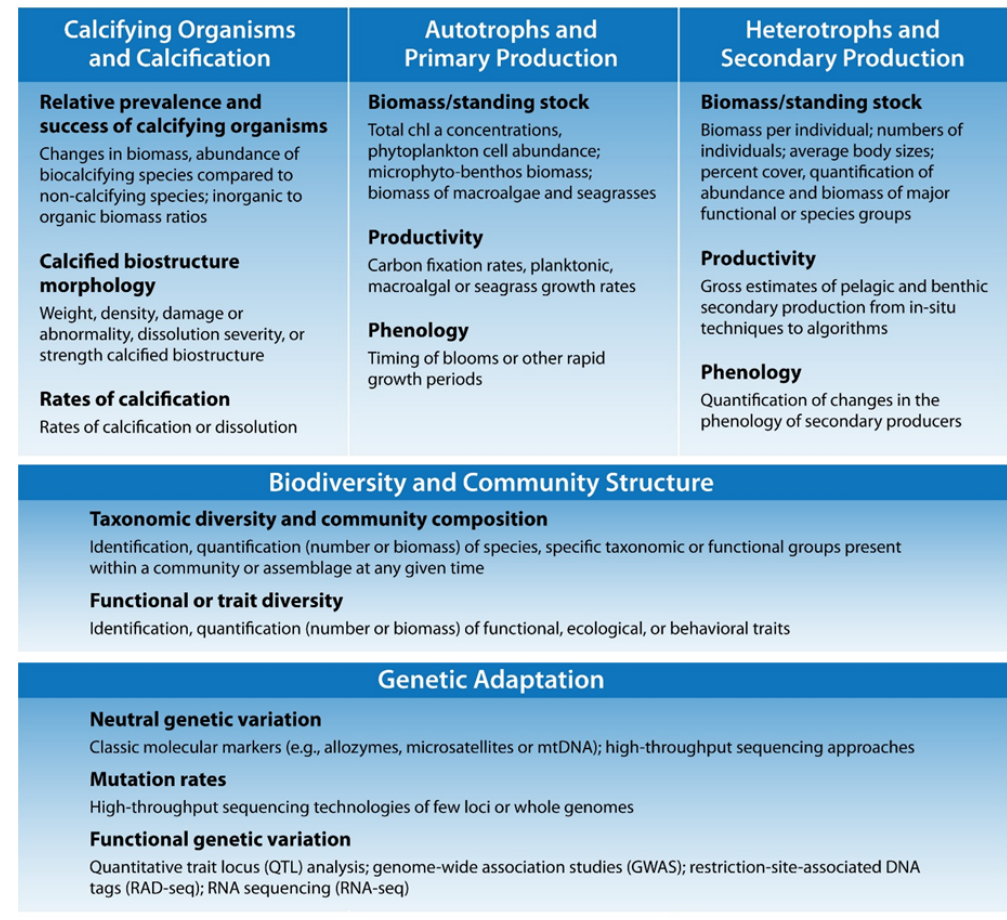
Figure 1. Five fundamental ecosystem traits identified as potentially sensitive to ocean acidification and their observable